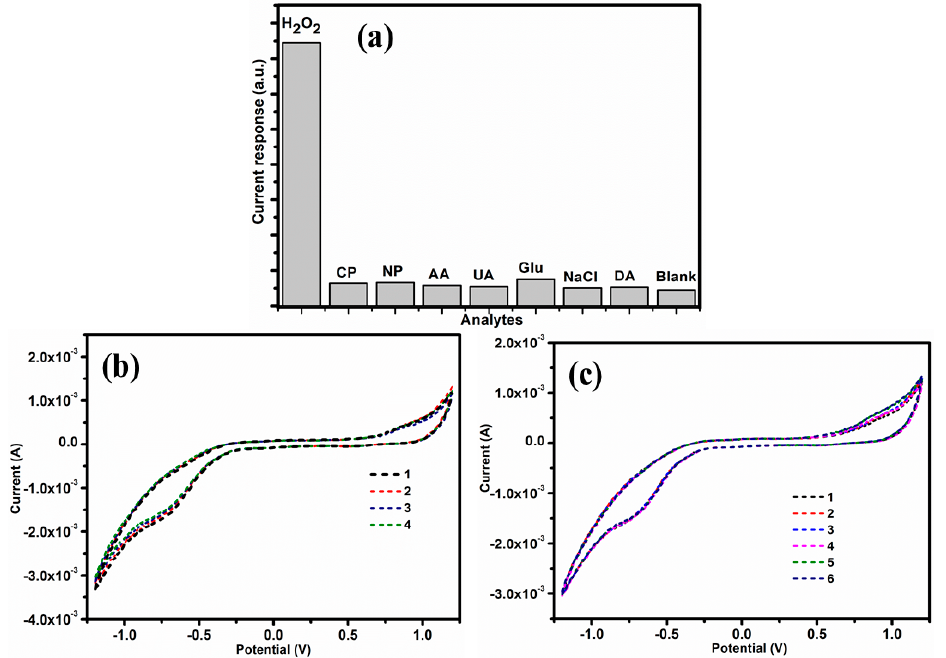
Figure 8. ( a ) Selectivity test of Fe 3 O 4 /Gr/CC with various interference, ( b ) repeatability, and ( c ) re- producibility test.